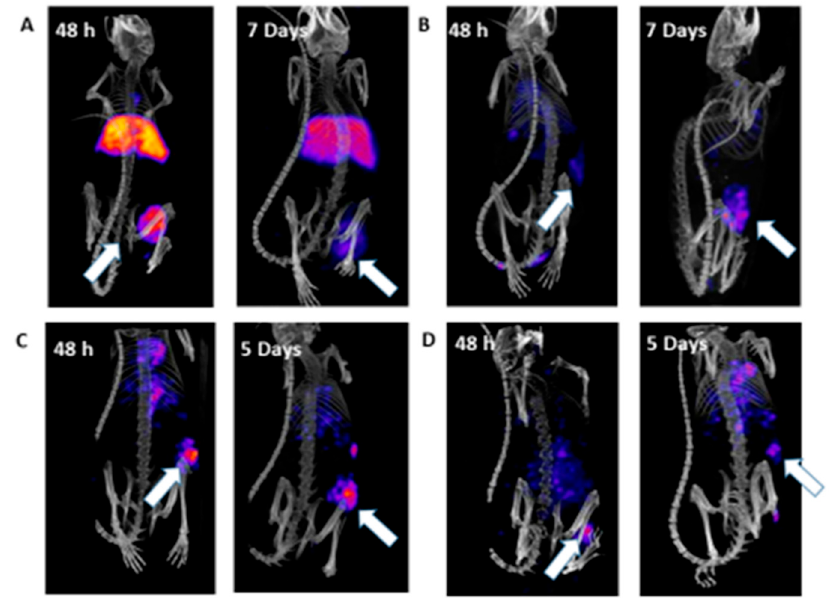
Figure 1. Effect on activity distribution of chelator and chelate-to-antibody ratio. ( A ) 111 In-DTPA- hu5A10 ratio 3:1 at 48 h and 7 days; ( B ) 111 In-DTPA-hu5A10 ratio 12:1 at 48 h and 7 days; ( C ) 111 In-DOTA-hu5A10 3:1 at 48 h and 5 days; ( D ) 111 In-DOTA-hu5A10 ratio 12:1 at 48 h and 5 days. There was a large shift in activity distribution for DTPA, but not as large as a difference as was seen for 111 In-DOTA-hu5A10. This can be seen in a clear shift from high liver uptake for ratio 3:1 to high tumor uptake for ratio 12:1.